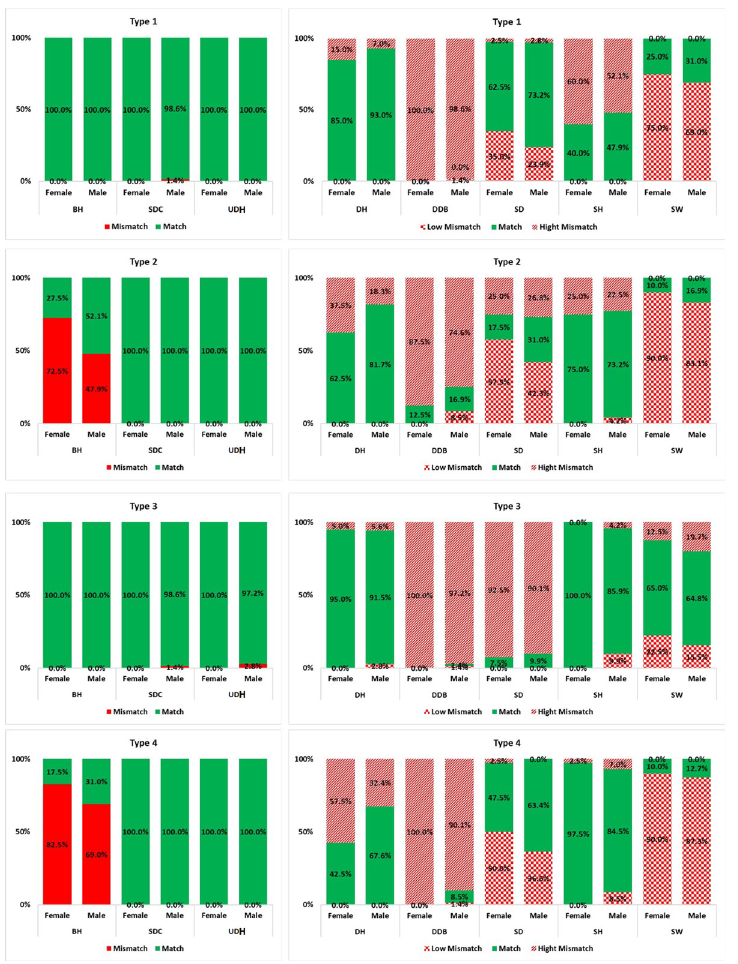
Fig 6. Mismatch percentages considering the type of furniture and